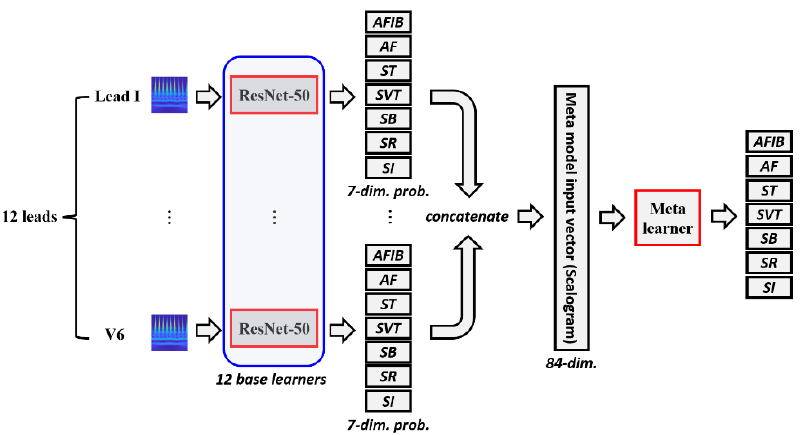
Figure 2. Architecture of single-modal stacking ensemble for scalogram images. For each lead, scalogram images are fed to a pretrained ResNet-50 model. The 7-dimensional output probability vector from each lead is concatenated to make an 84-dimensional vector. Then, the 84-dimensional vector is fed into a meta learner that outputs prediction values for the 7 classes.